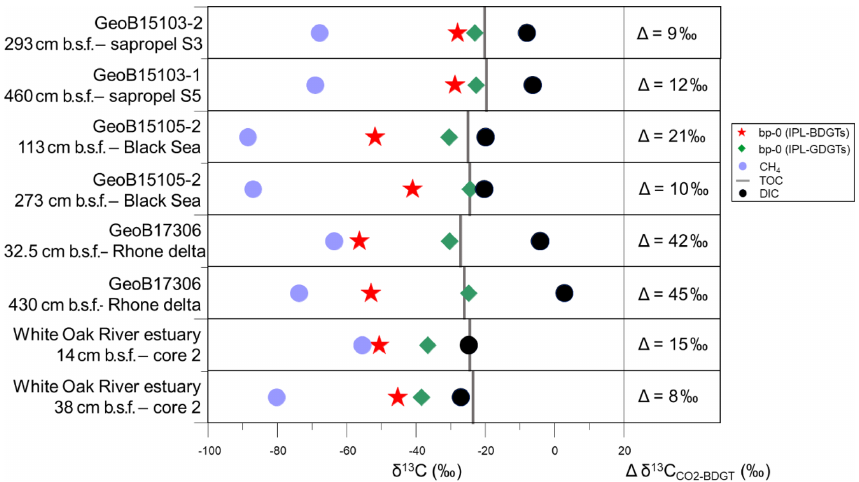
Figure 5. Stable carbon isotopic composition ( δ 13 C) of bp-0 (IPL-BDGTs; red stars), bp-0 (IPL-GDGTs; green diamonds), CH 4 (light blue circles), TOC (grey bars) and DIC (black circles) in six selected marine sediment samples from the Mediterranean Sea, Black Sea and White Oak River estuary (Meador et al., 2015). Lipid samples were measured in duplicate and are presented as averages; deviations between individual measurements were generally smaller than the symbol size. On the right panel, the difference ( (cid:49) ) between δ 13 C CO 2 and δ 13 C BDGT is computed for each sample. δ 13 C CO was derived from δ 13 C DIC based on an isotope fractionation of − 10 . 7‰ between 2 dissolved CO 2 and DIC, considering in situ temperatures to be below 10 ◦ C, according to Mook et al.